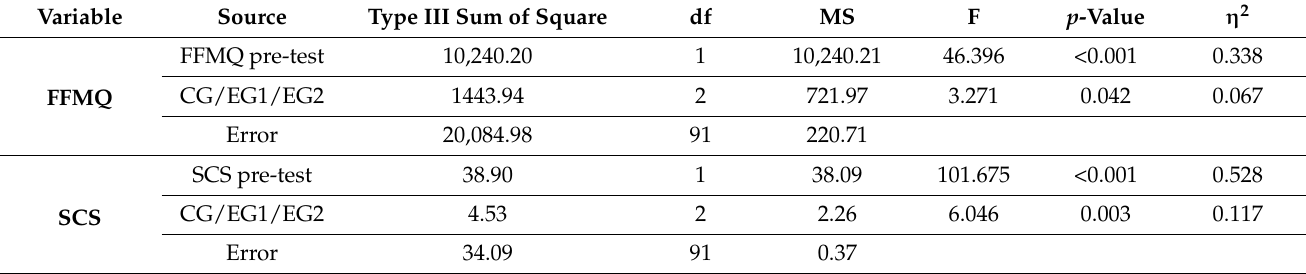
Figure 2. Line graphs of the FFQM and SCS scores of the different groups in the three temporal points. Table 4. Comparison between groups in post-test scores, controlling pre-test scores, using ANCOVA. Variable